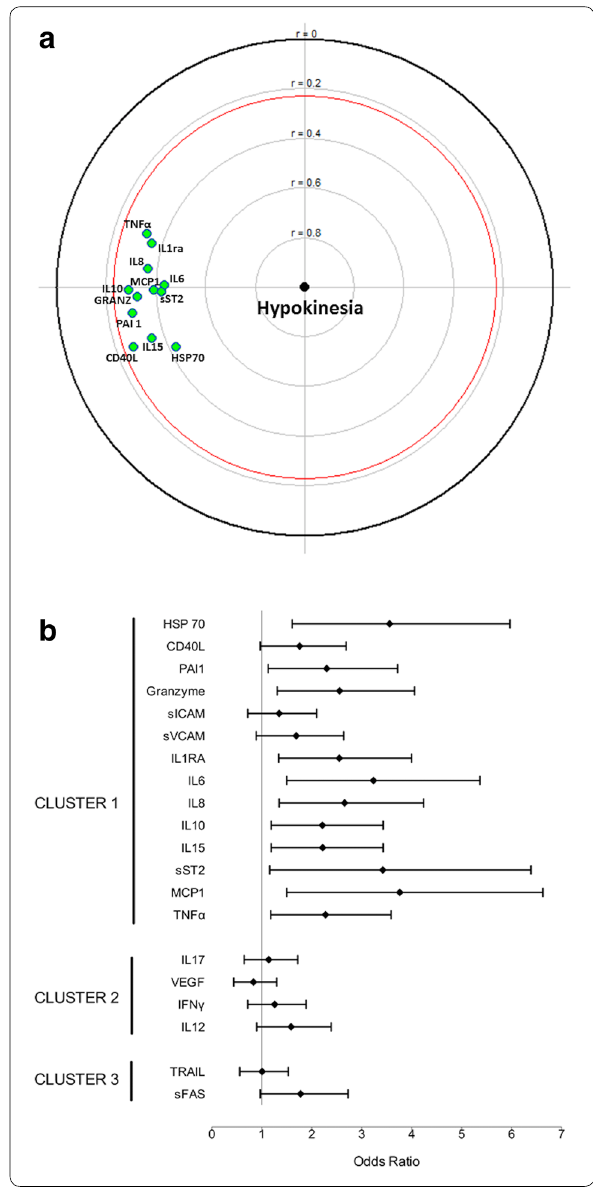
Fig. 2 Forest plot for odds ratios ( a ) and focused principal component analysis (FPCA, b ) for the association between sepsis mediators and septic myocardial dysfunction. FPCA is a simple graphical display of correlation structures focusing on a particular dependent variable. The display reflects primarily the correlations between the dependent variable and all other variables (covariates) and secondarily the correlations among the covariates. The dependent variable (septic myocardial dysfunction, SMD) is at the center of the diagram, and the distance of this point to a covariate faithfully represents their pairwise Spearman correlation coefficient (using ranked values of continuous variables). Green covariates are positively correlated with the dependent variable. For parsimony, only covariates significantly correlated with the dependent variable (with a p value < 0.05 and inside the red circle) are displayed. The diagram also shows relationships between covariates as follows: Correlated covariates are close (for positive correlations, allowing identification of clusters) or diametrically opposite vis‑à‑vis the origin (for negative correlations), whereas independent covariates make a right angle with the origin. See text for sepsis mediators’ abbreviations